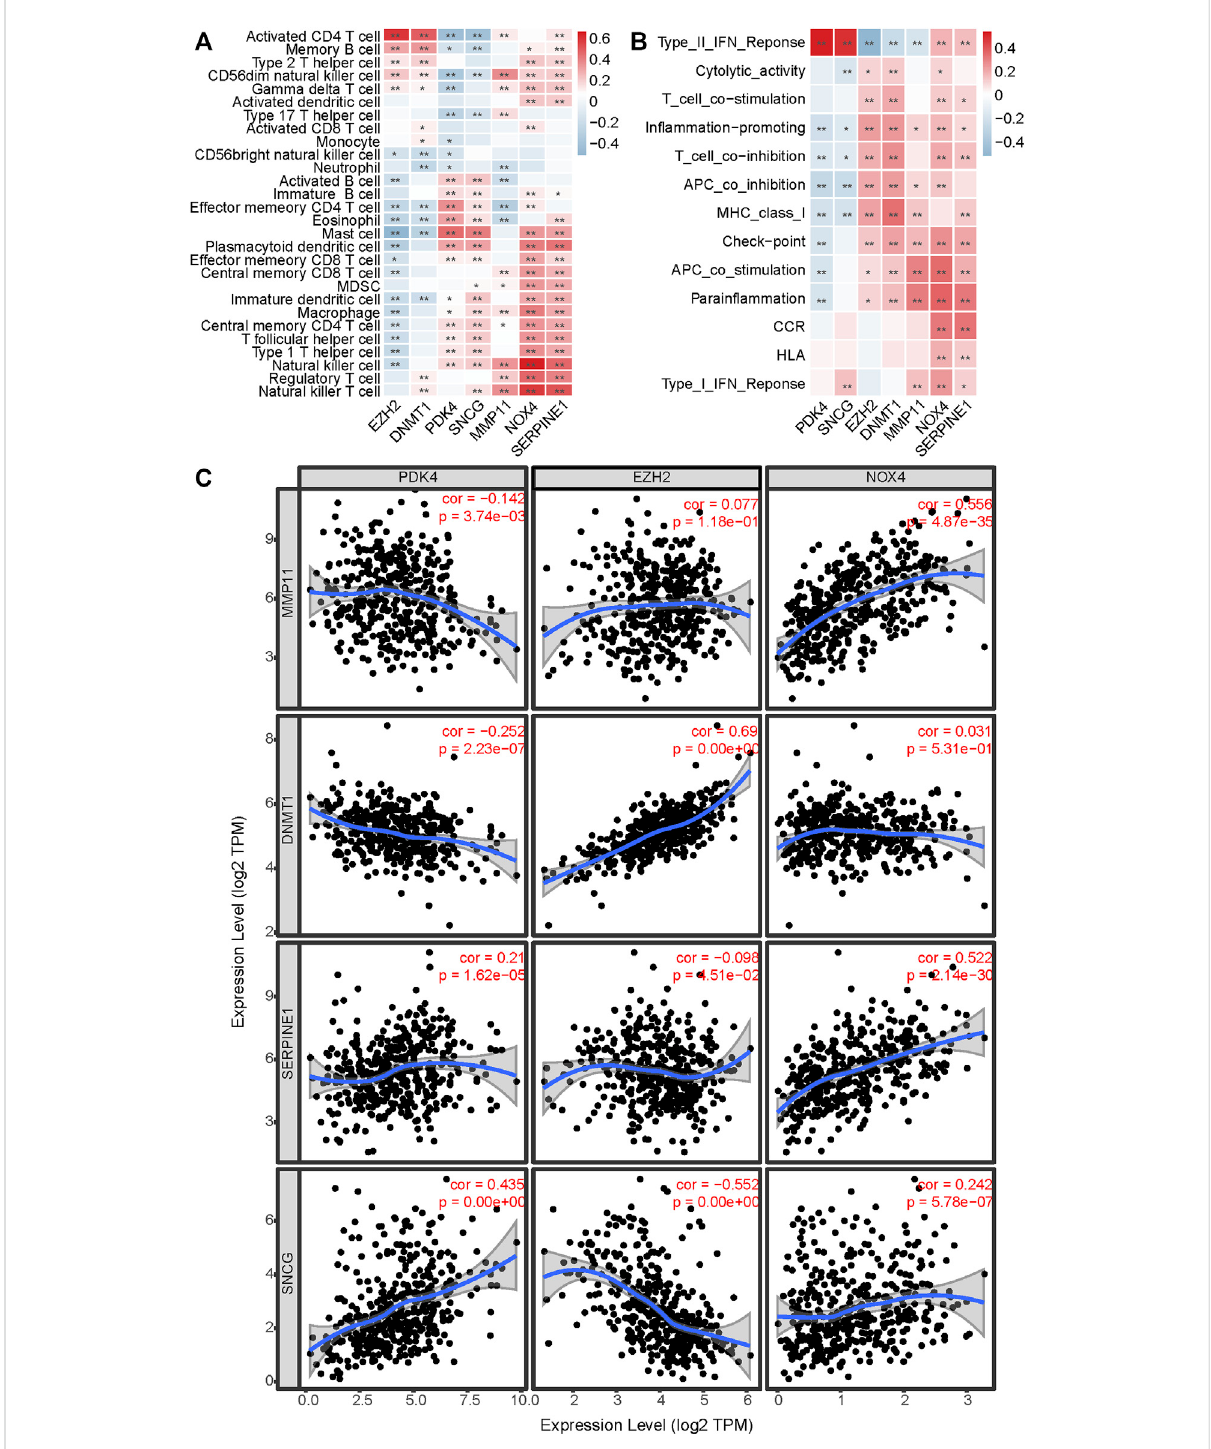
FIGURE 8 Estimation of the correlation between markers and immune in fi ltration. The correlation between the seven markers and (A) 28 immune cells and (B) 13 immune pathways showed by heat maps. (C) The linear relation of each of the two markers in the model is predicted by TIMER. * < 0.05, ** <